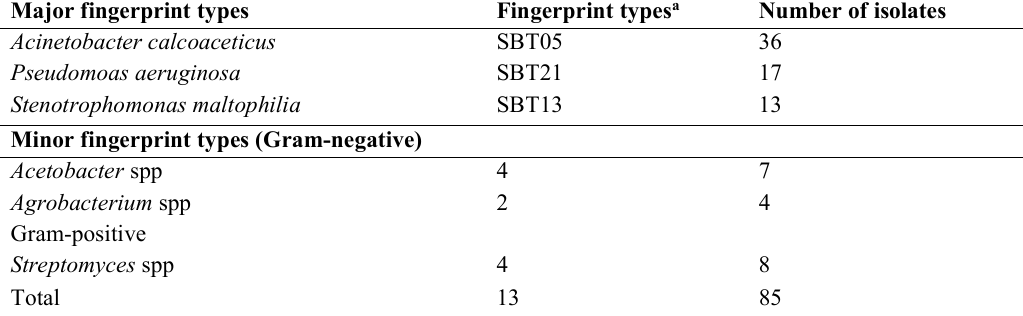
Table 2. SDS-PAGE fingerprint types and number of endophyte isolates in the leaves of sugar